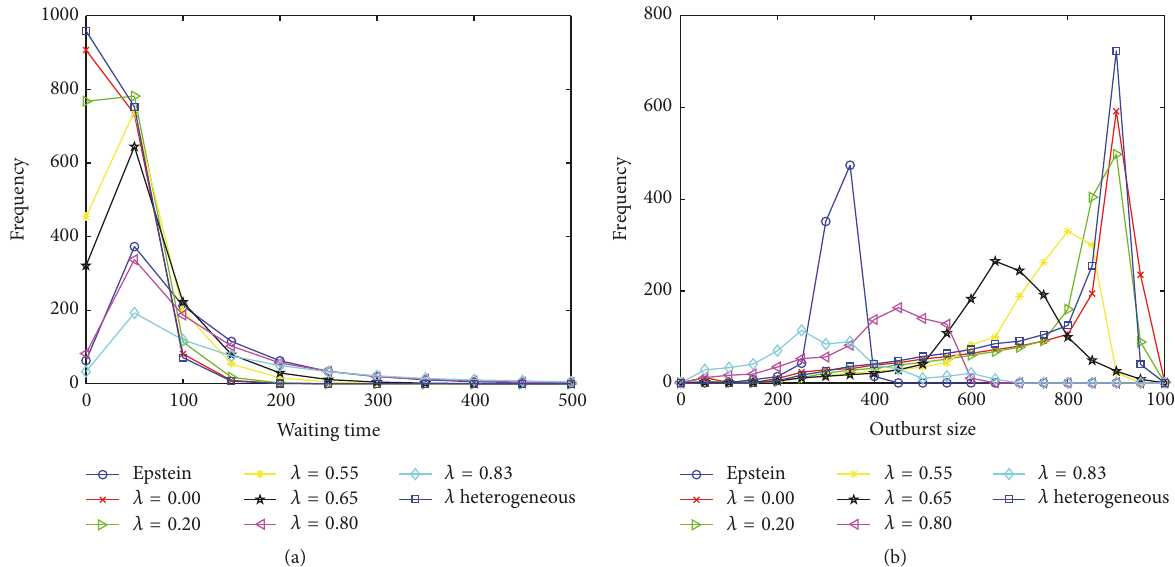
Figure 3: (a) Distribution of waiting times. The change of the distribution of the waiting times according to the saving parameters 𝜆 = [0.00, 0.20, 0.55, 0.65, 0.80, 0.83] is shown, which are drawn with lines and circles of red, green, yellow, black, magenta, and cyan, respectively. The line with squares in blue corresponds to the case with heterogeneous saving in the system, while the line with blue circles corresponds to the distribution obtained with the original Epstein model. (b) Distribution of burst sizes. The changes in the size distribution of the burst are shown for the saving parameters 𝜆 = [0.00, 0.20, 0.55, 0.65, 0.80, 0.83] , which is drawn with lines and circles of red, green, yellow, black, magenta, and cyan, while the blue line with squares corresponds to the case with heterogeneous saving in the system. The blue line with circles corresponds to the Epstein model.